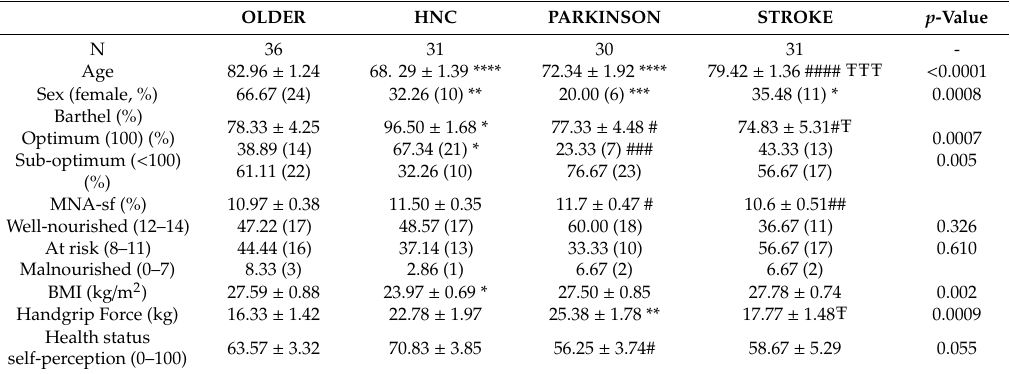
patients had the lowest (66.67%, p < 0.01) (Table 2).